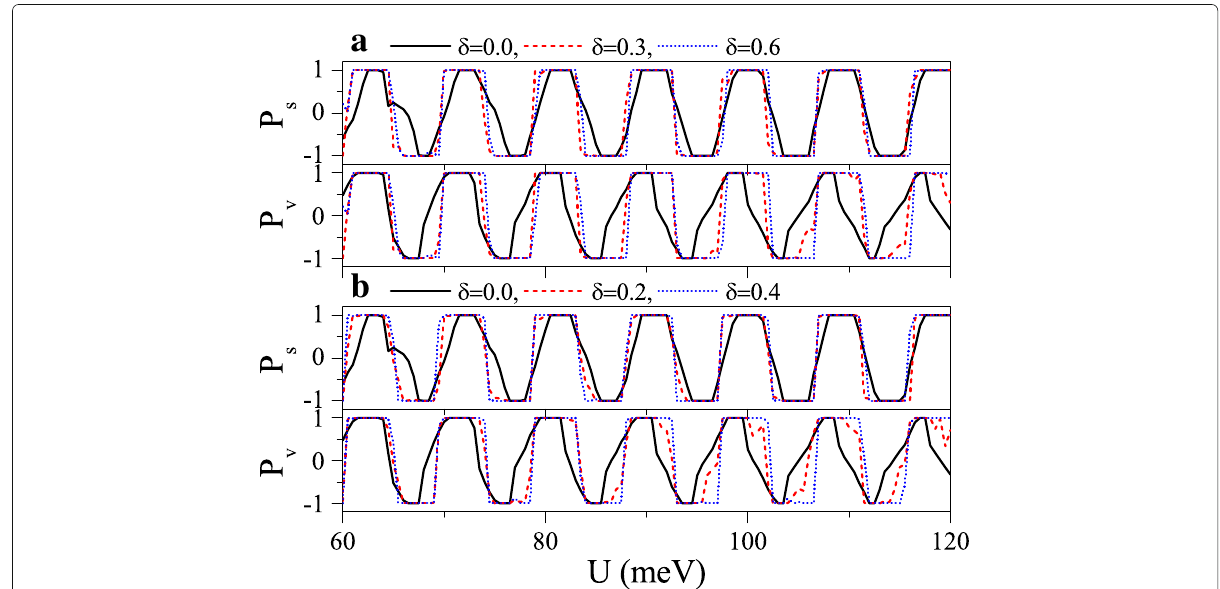
spin polarization, and valley polarization are shown in Figs. 10 and 11. We set disorder situations of (cid:2) z and h fluctuate around their mean values, given by (cid:9) (cid:2) z (cid:10) = (cid:9) h (cid:10) = h (cid:2) z 0 and 0 , respectively. The fluctuations are given by